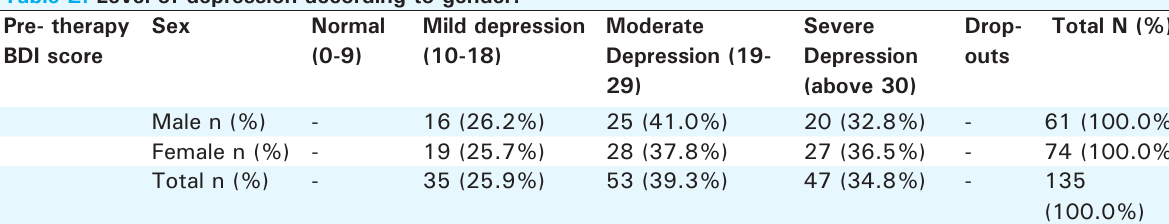
Table 2. Level of depression according to